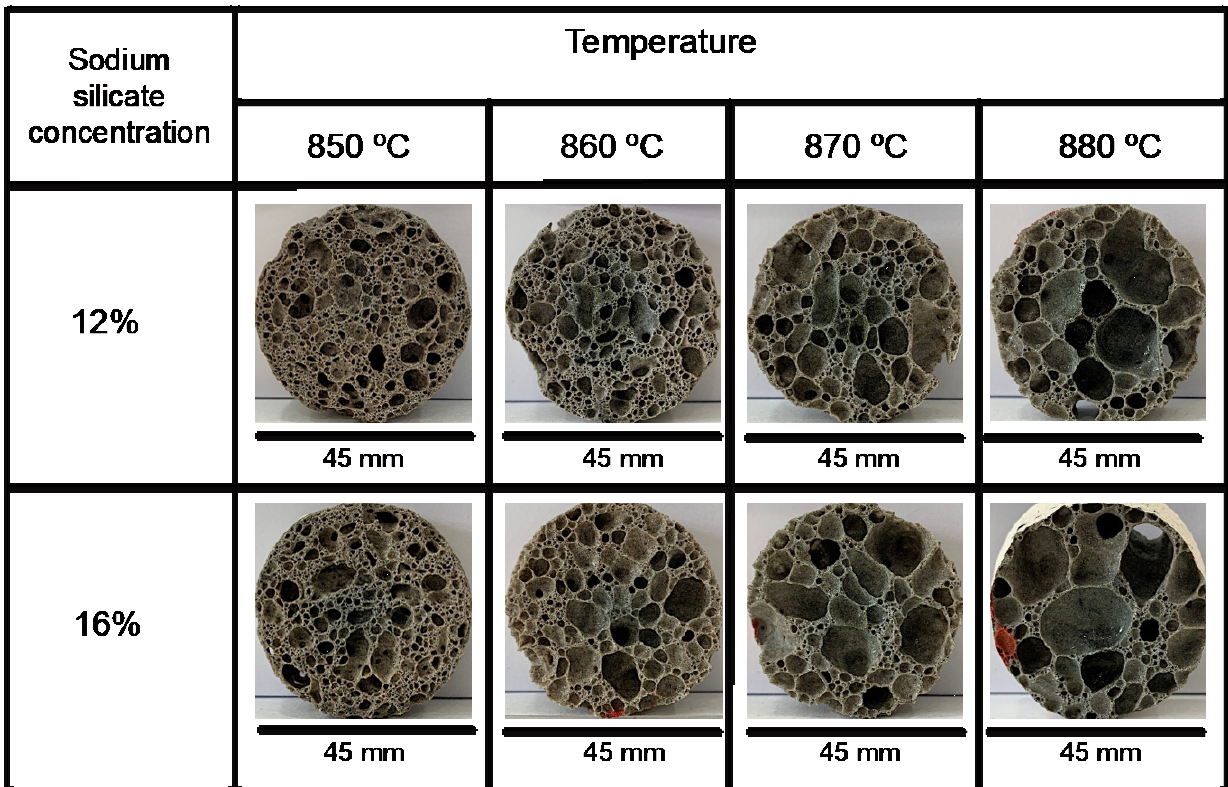
Figure 11. Effect of the sintering temperature on the development of the porosity of the foams using a time of 45 min.